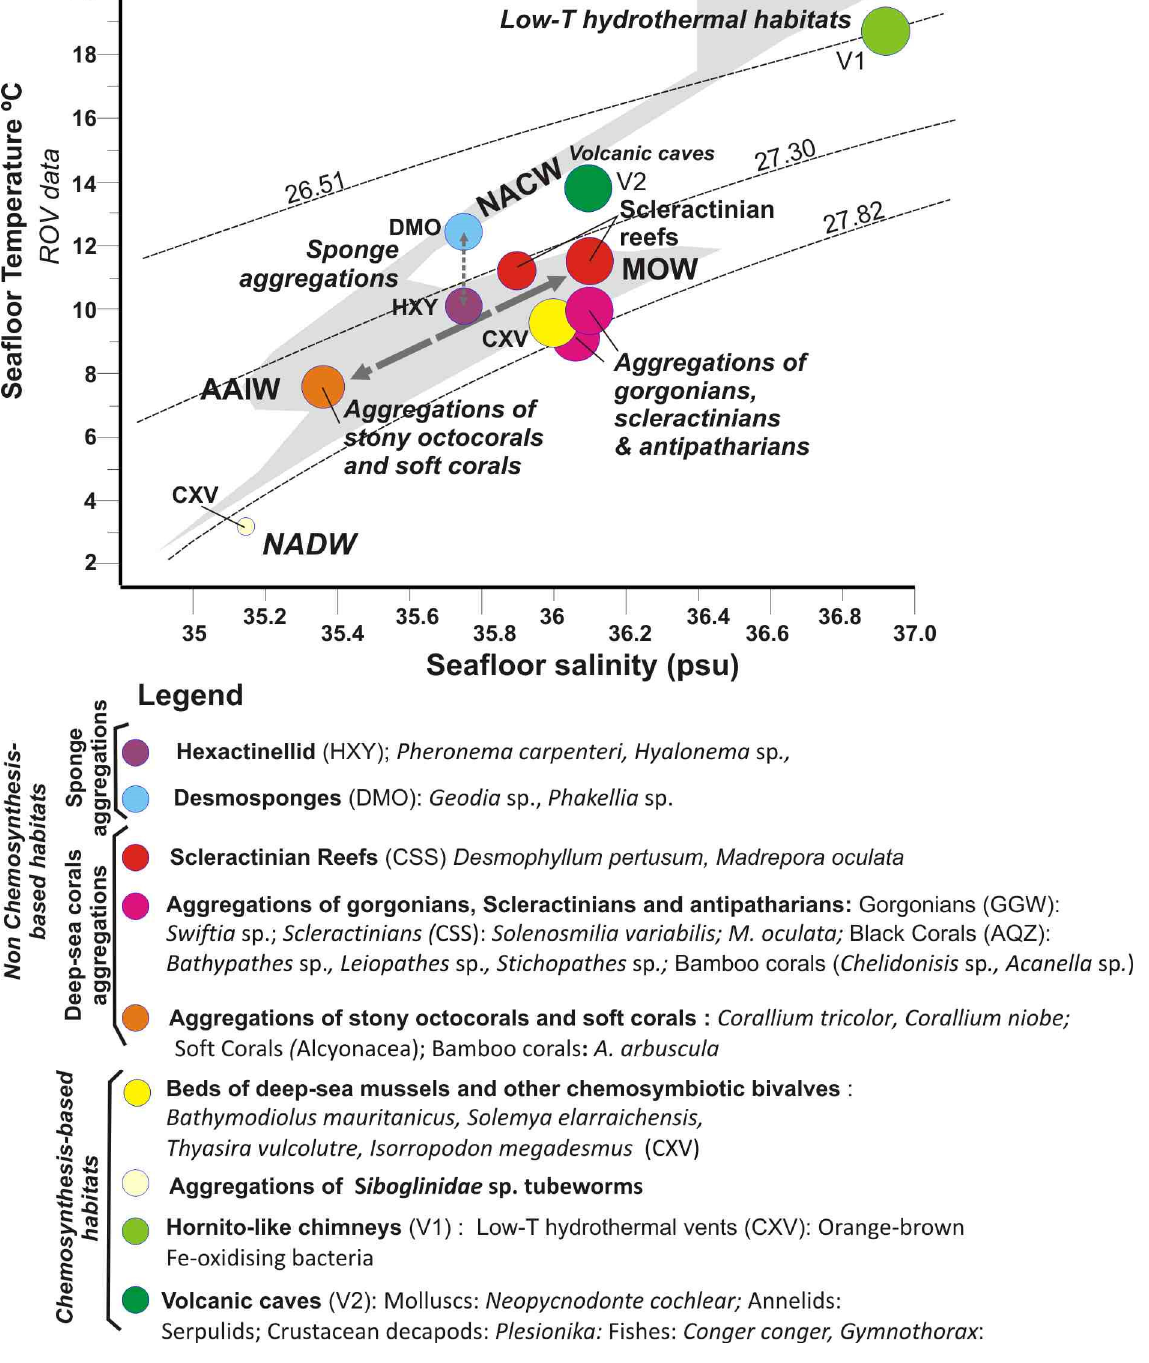
Figure 13. T-S diagram for the in-situ water mass conditions measured with the ROV for each of the type of habitats (full data listed in Supplementary Table S3). Background grey pattern corresponds to CTD data and dashed lines (from top to bottom) to constant potential density (isopycnal) contours = 26.51, 27.30 and 27.82 dividing four regions corresponding to the main different water masses defined by [33]: NACW, AAIW, MOW and NADW defined by [33]. Legend: FAO Taxa Classification and Codes for Vulnerable Marine Ecosystems (VMEs) (http://www.fao.org/in-action/vulnerable-marine- ecosystems/vme-database, accessed 1 December 2020).